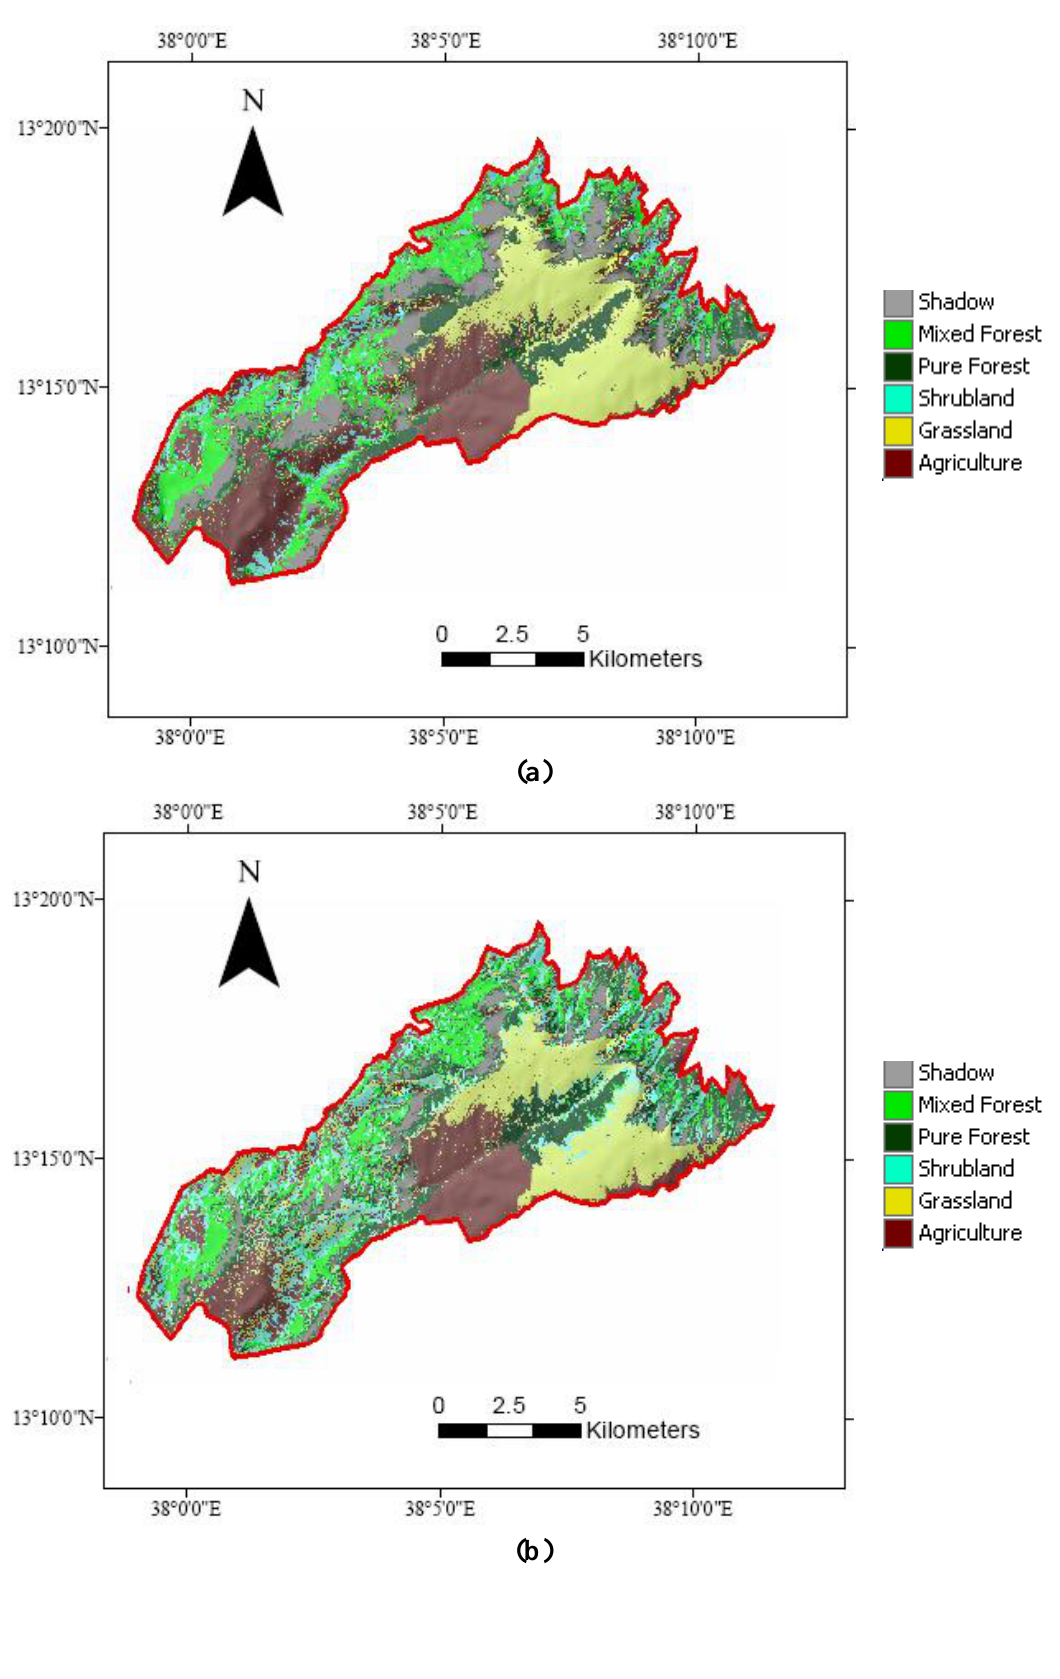
Figure 2. LC maps of: ( a ) 1984, ( b ) 2003 and ( c ) land cover change